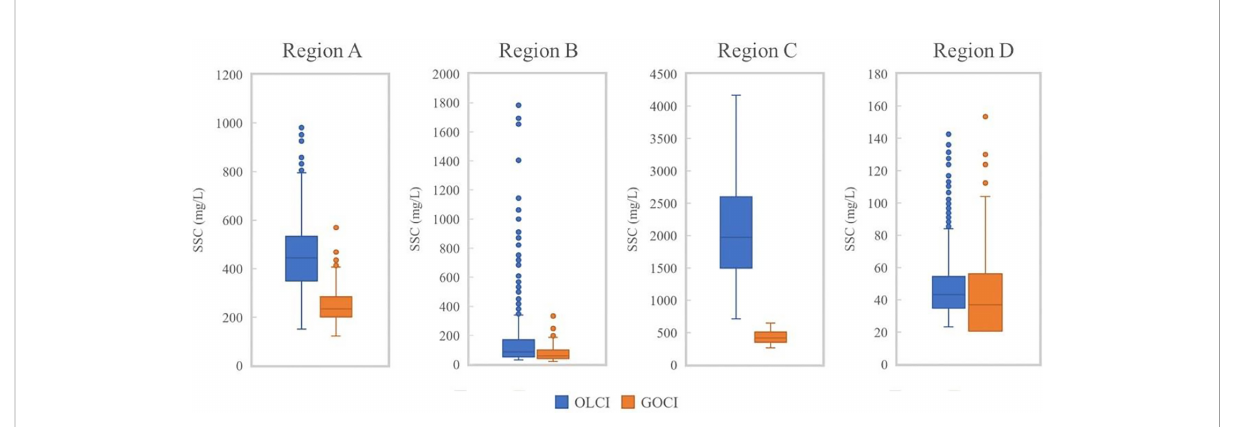
FIGURE 12 Box line plots of SSC in four experimental regions based on 2017 data.